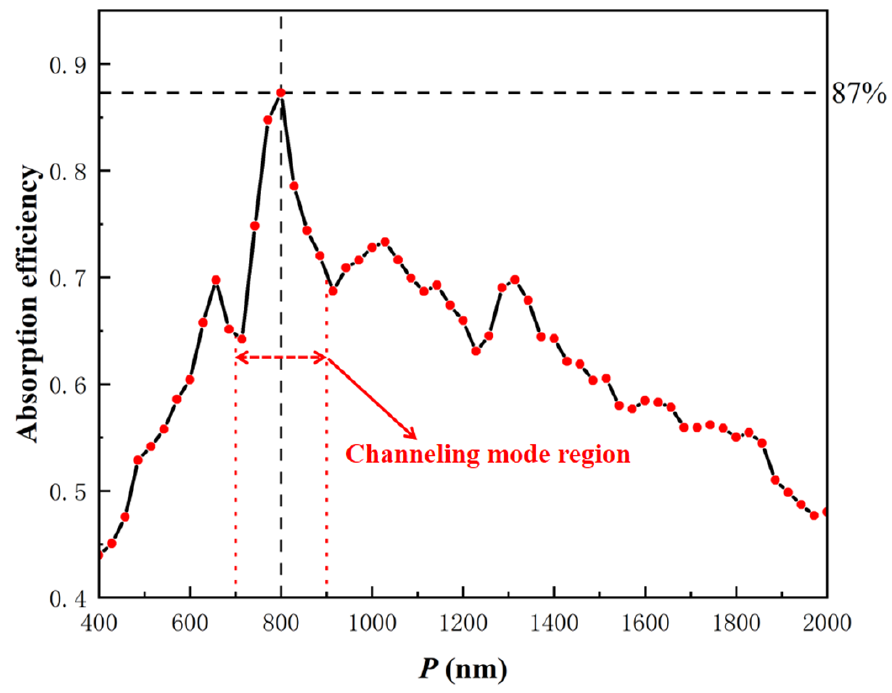
Figure 2. Simulated absorption efficiency at λ = 1.31 μ m by scanning period, the red dot indicates the sampling point (2 R / P = 0.7, D = 750 nm).